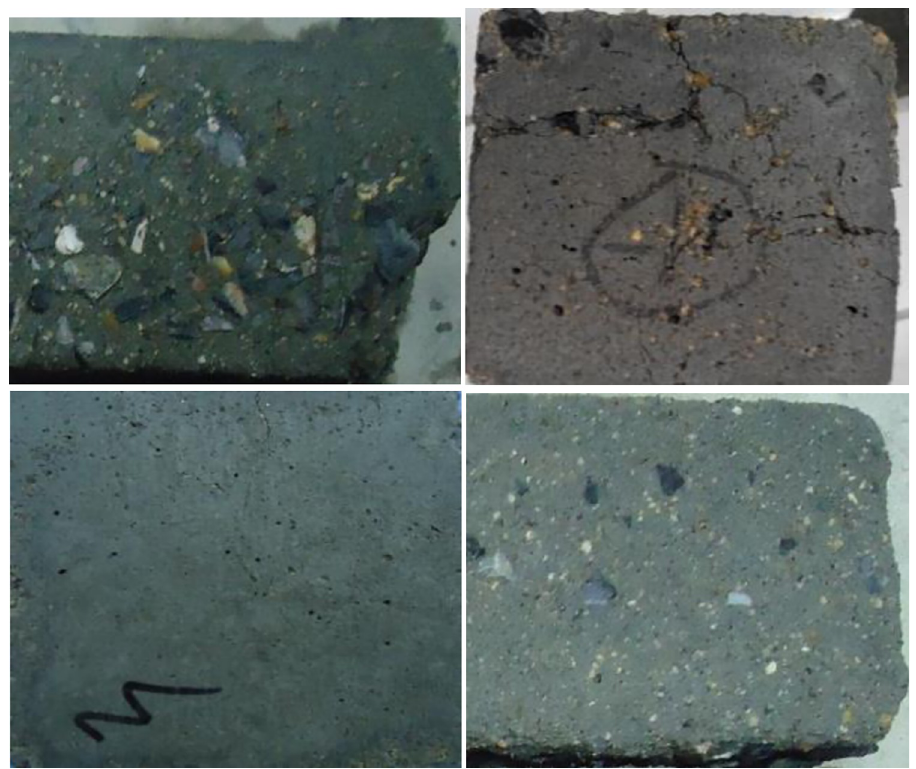
Fig 10. Concrete specimens with different GO exposed to the freeze-thaw cycles 200